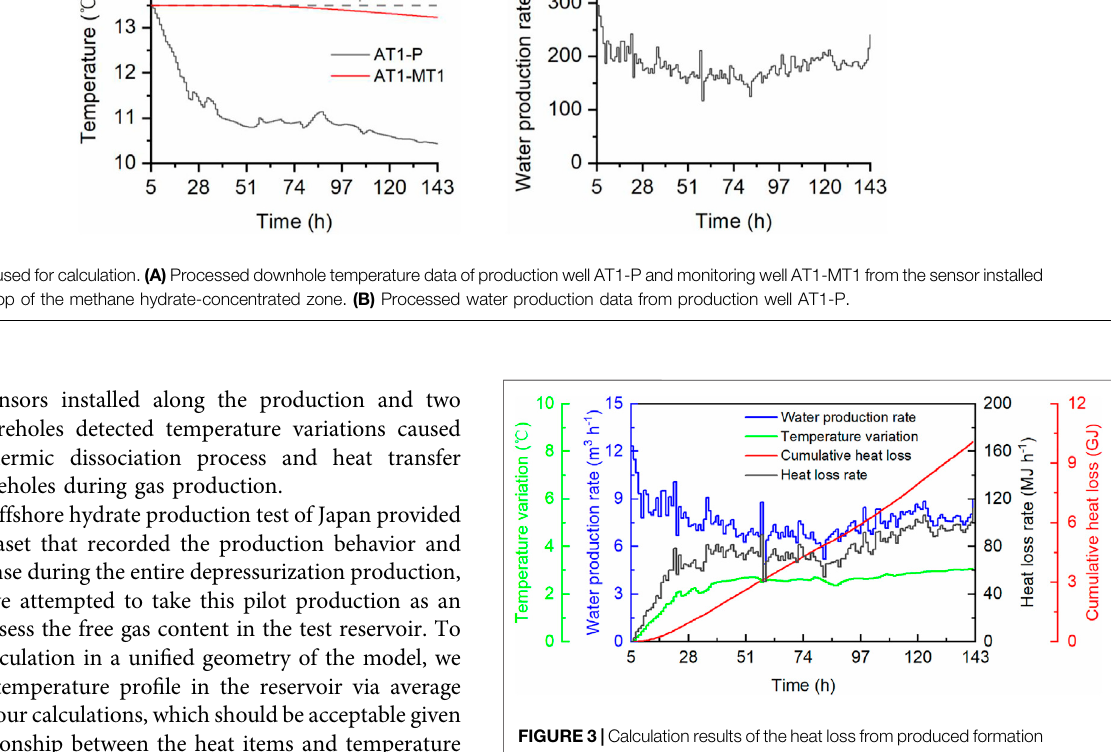
Frontiers in Earth Science |